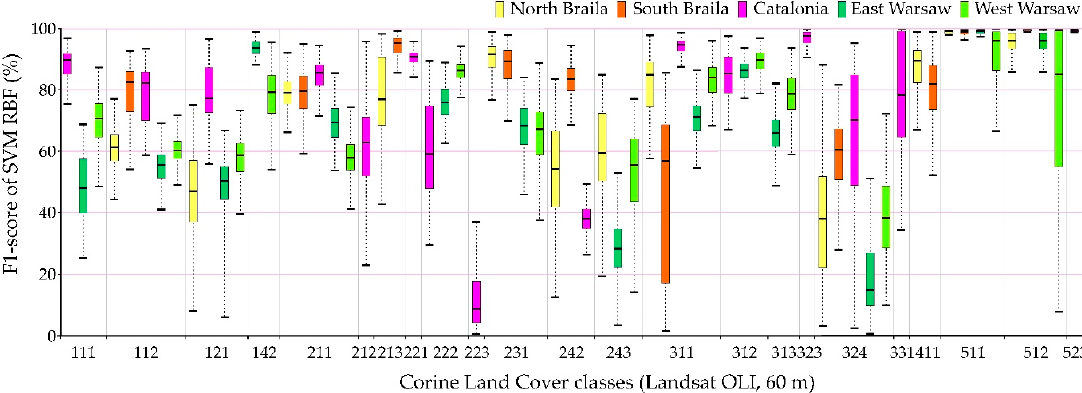
Figure 11. The best classification results (F1-score) achieved from the SVM radial kernel function (RBF) classifier and mul- titemporal Landsat 8 Operational Land Imager (OLI) images.